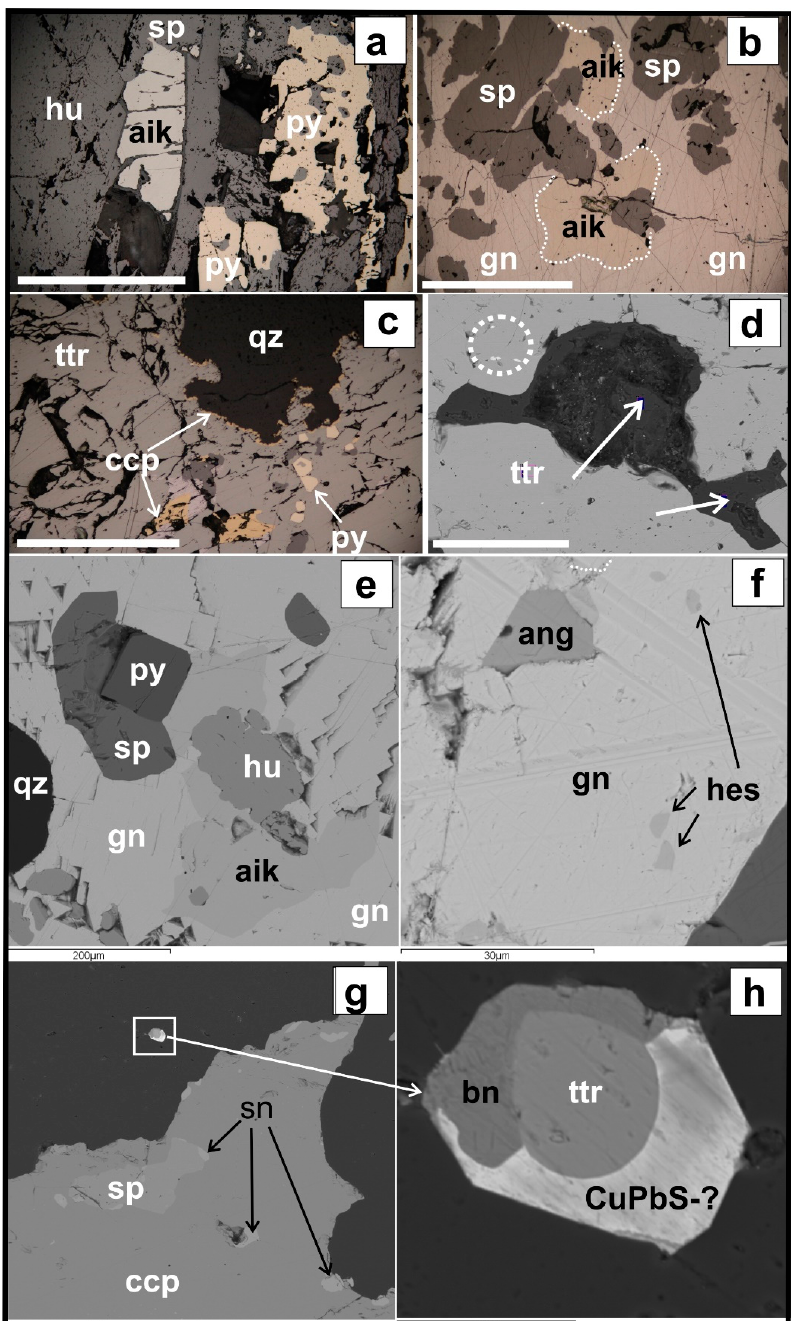
Figure 3. Petrographic characteristics of the ore minerals. Photomicrographs of polished sections ( a – c ) and BSE images ( d – h ) of the Inkur ( a – d ) and the Kholtoson ( e – h ) deposits. ( a ) interrelationships of hubnerite, aikinite, and sphalerite, corroded pyrite grains; ( b ) sphalerite and aikinite (white dotted line) grains in the galena; ( c ) chalcopyrite and pyrite in tetrahedrite aggregate; ( d ) rosenbergite (white arrows) enclosed in tetrahedrite, with microinclusions (dotted line) of hessite; ( f ) inclusions of hessite (arrows) in galena and anglesite segregation; ( g ) sphalerite and stannite enclosed in chalcopyrite aggregate; ( h ) intergrowths of bornite, tetrahedrite, and unknown CuPbS phase. Scale bar length: ( a – c ) 1 cm, ( d ) 200 μ m. Abbreviations of the minerals: hu—hubnerite, sp—sphalerite, py—pyrite,